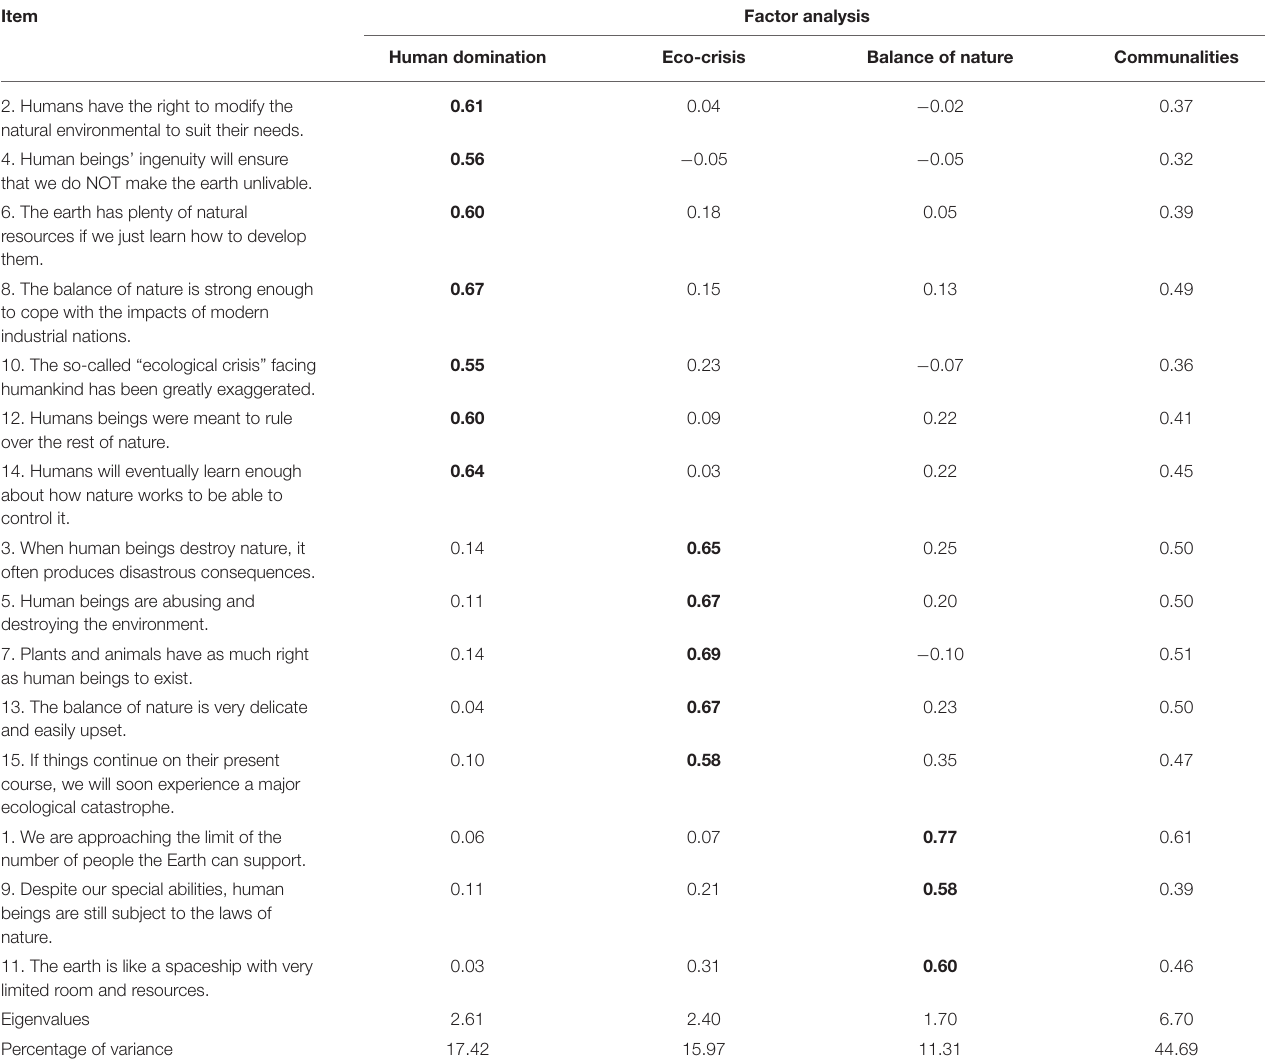
TABLE 3 | Factor analysis of environmental